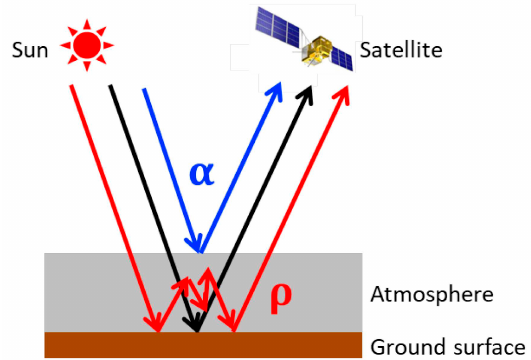
Figure 1. Schematic showing definitions of PPDF parameters α and ρ . The blue line shows the light-path length shortened because of light reflection, which is represented by α . The red line is the path length lengthened because of multiple light scattering, which is represented by ρ . The black line shows the basic geometrical path of light propagation.